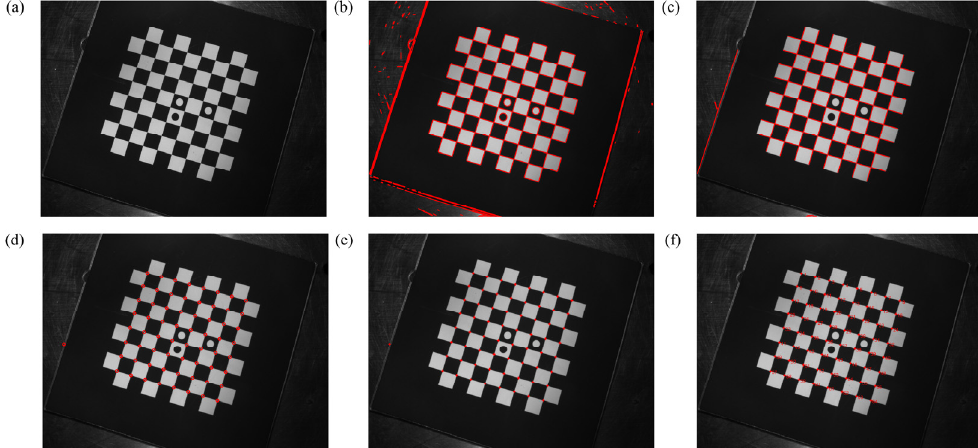
Figure 6. Corner-detection process: ( a ) original image, ( b ) image after straight-line detection by EDLines, ( c ) result after straight-line screening, ( d ) initial coordinate results of corner points, ( e ) result of corner points subpixel optimization, and ( f ) result after corner sorting.